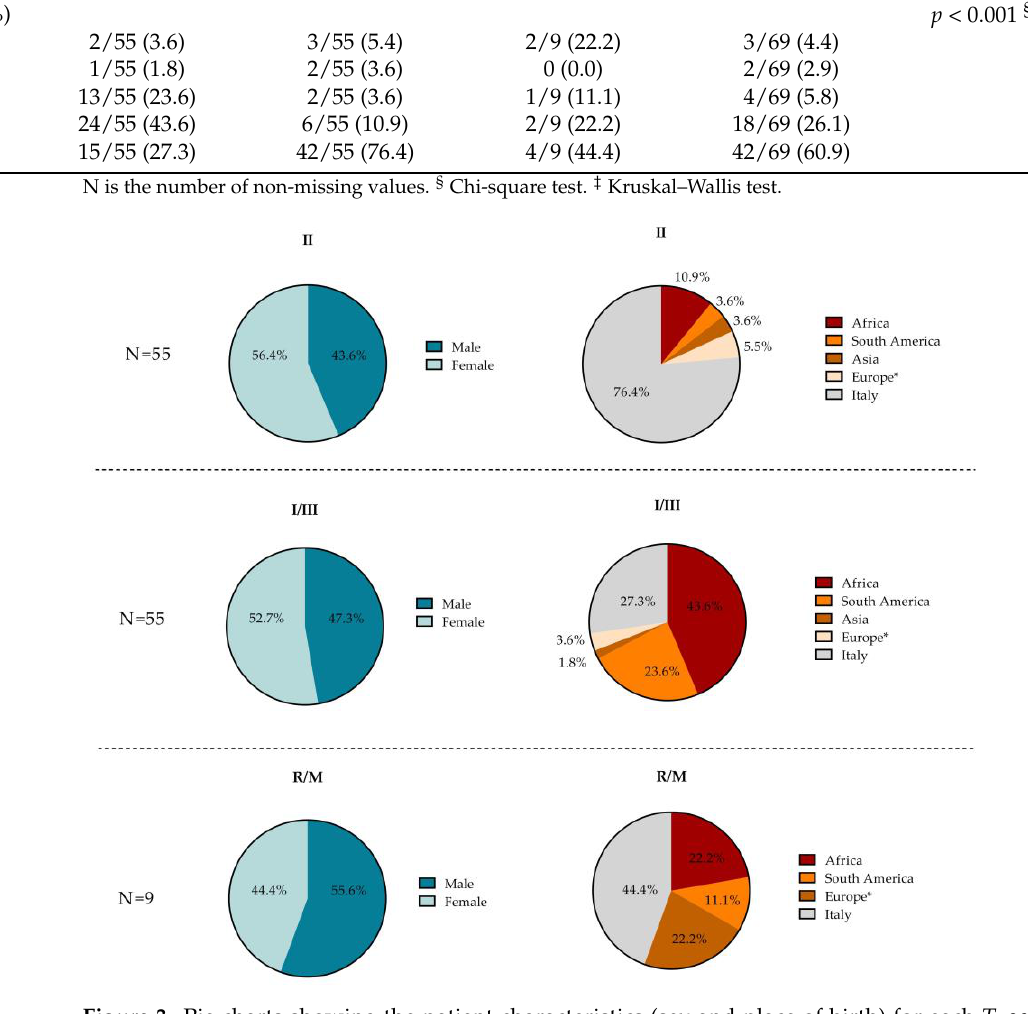
Figure 3. Pie charts showing the patient characteristics (sex and place of birth) for each T. gondii serotype (I – III, II, R/M) found in the overall study population. * Europe without